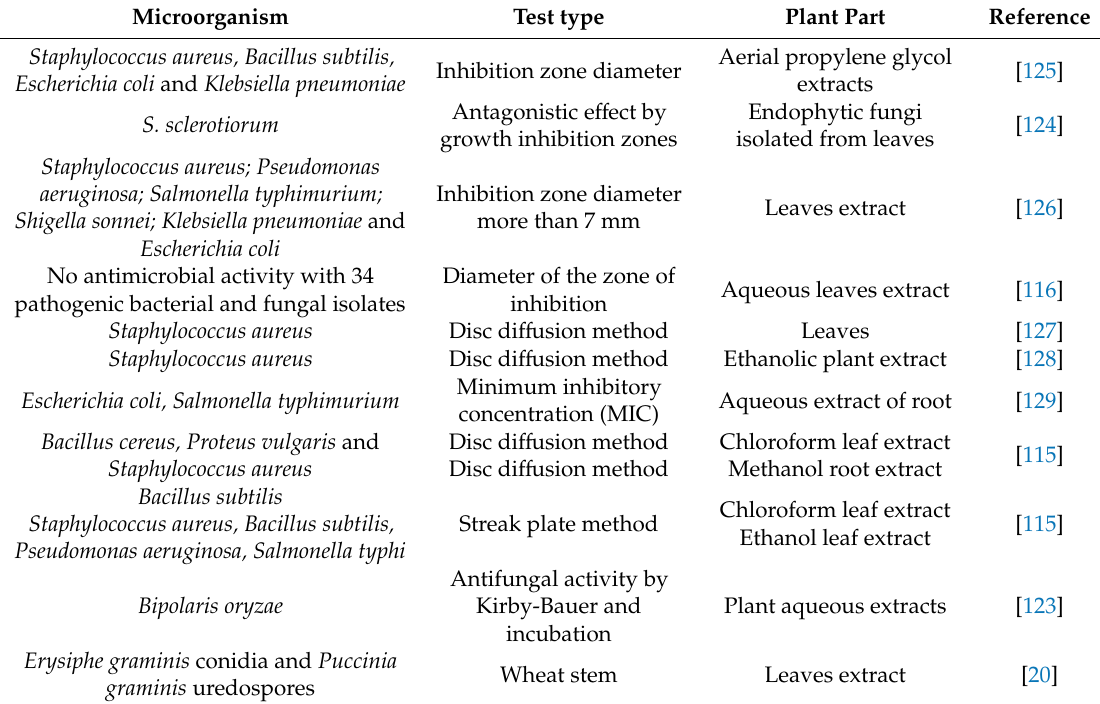
Table 4. Summary of the in vitro evidence of Symphytum species antimicrobial e ff